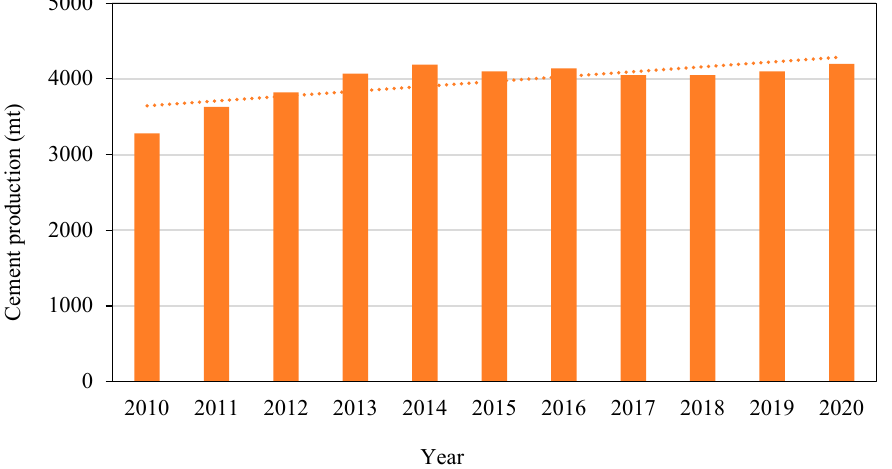
Figure 1. Worldwide cement production in Metric Tonnes, 2010–2020 [7].